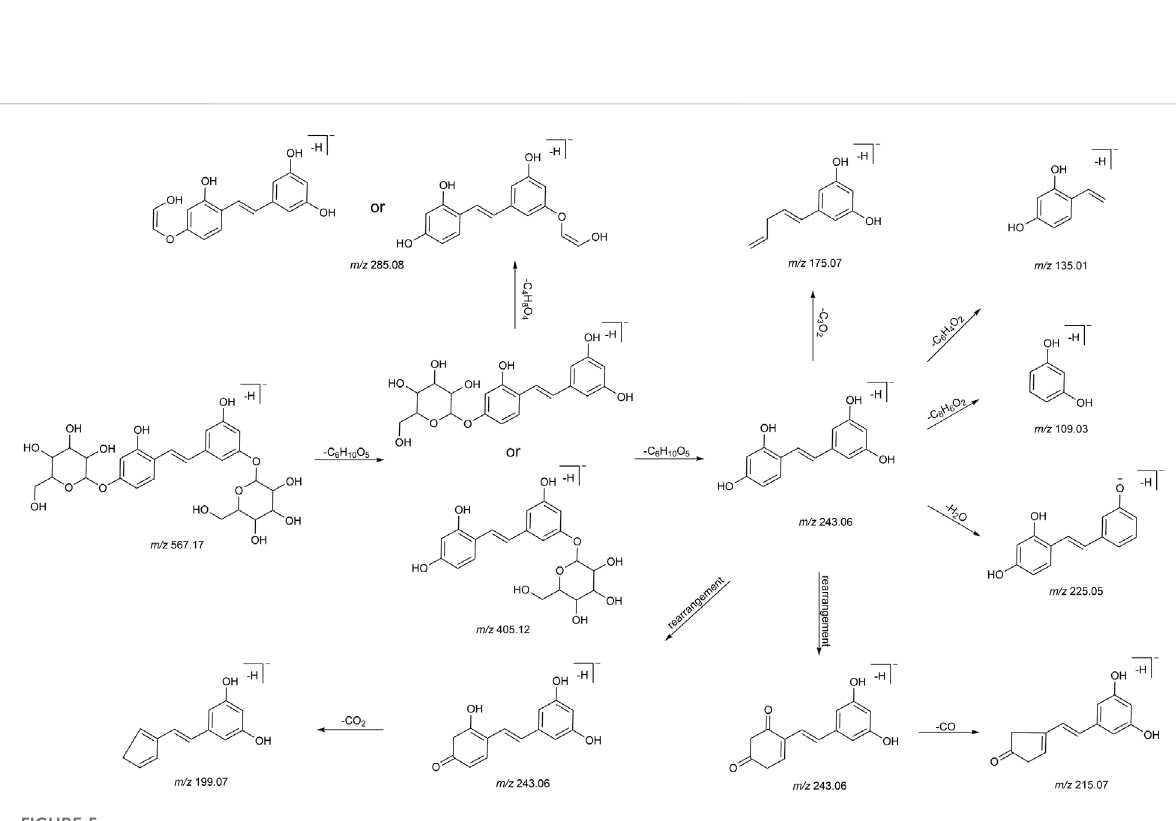
FIGURE 5 The mass fragmentation behavior of Mulberroside A in negative ion